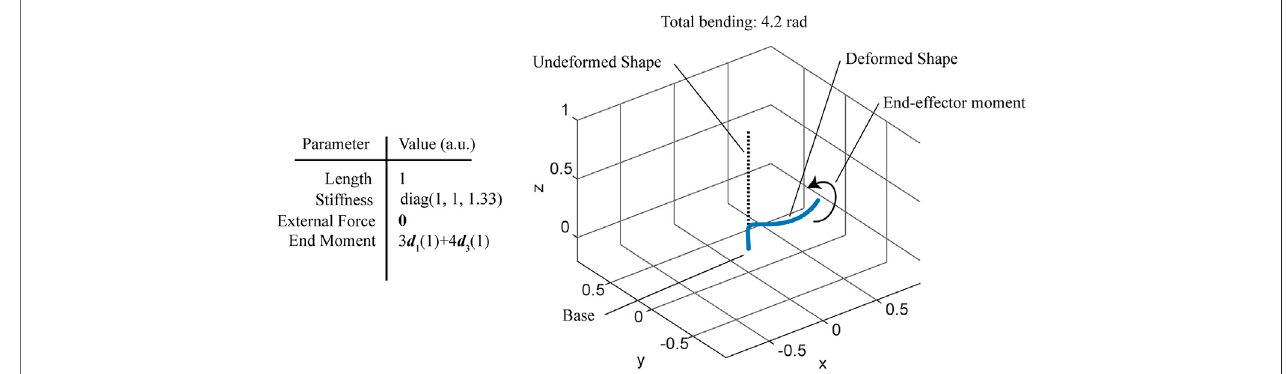
FIGURE 3 | Simulation of a cantilevered rod under a combined bending and twisting concentrated moment, forming a helix.